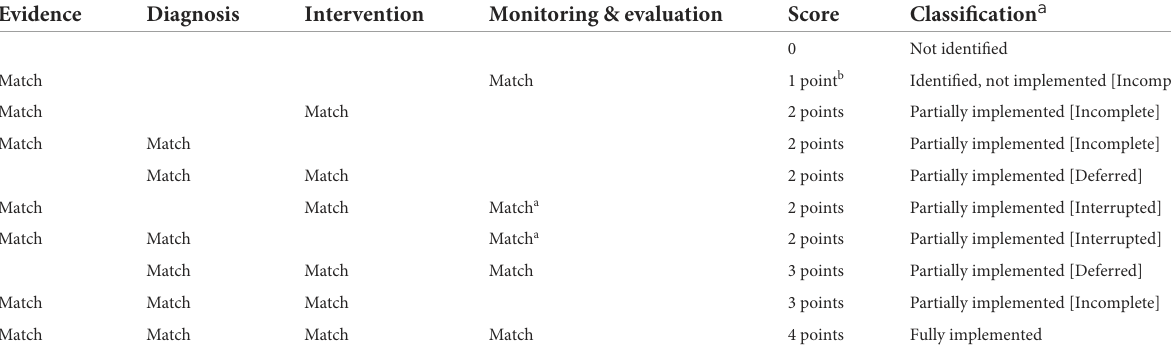
TABLE 1 Recommendation-level match criteria for the expected care plans (ECP) in the diabetes ECP analyzer.